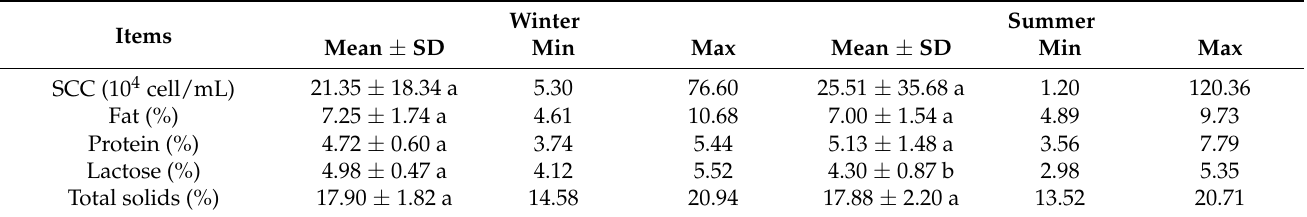
Table 2. Mean ± SD and range of basic parameters of crossbred buffalo raw milk in winter and summer.